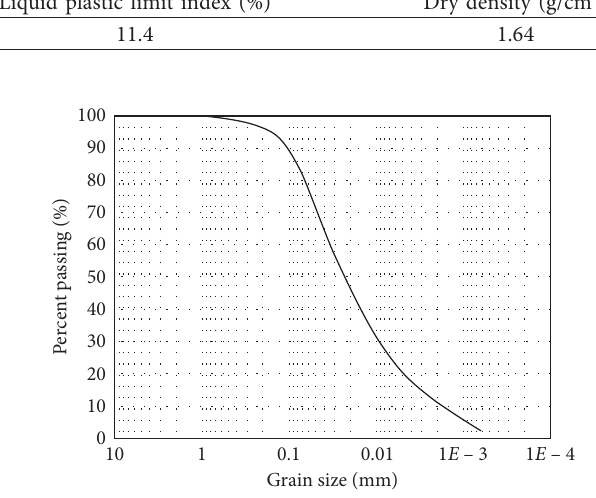
Figure 1: The grain size distribution of silty